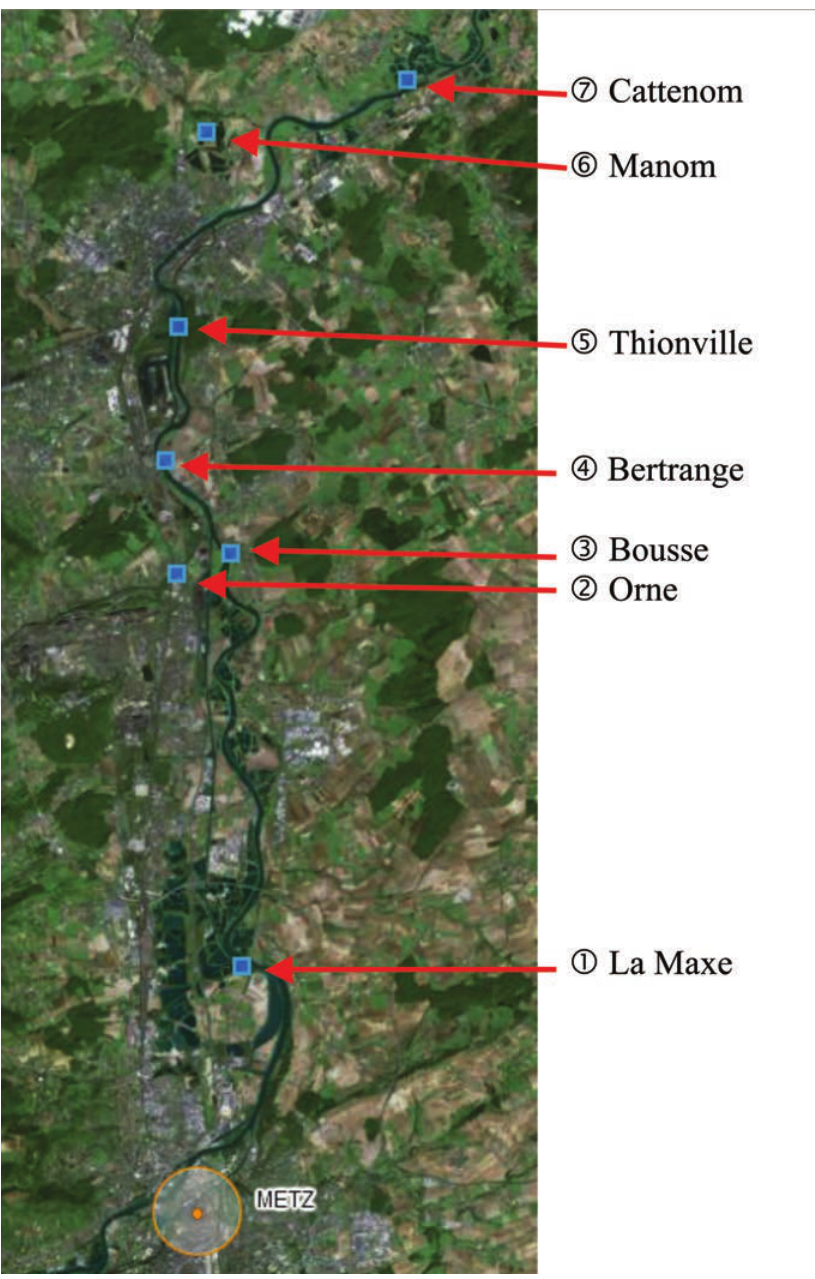
Figure 1. Moselle river watershed (Lorraine Province, France) sediment sampling